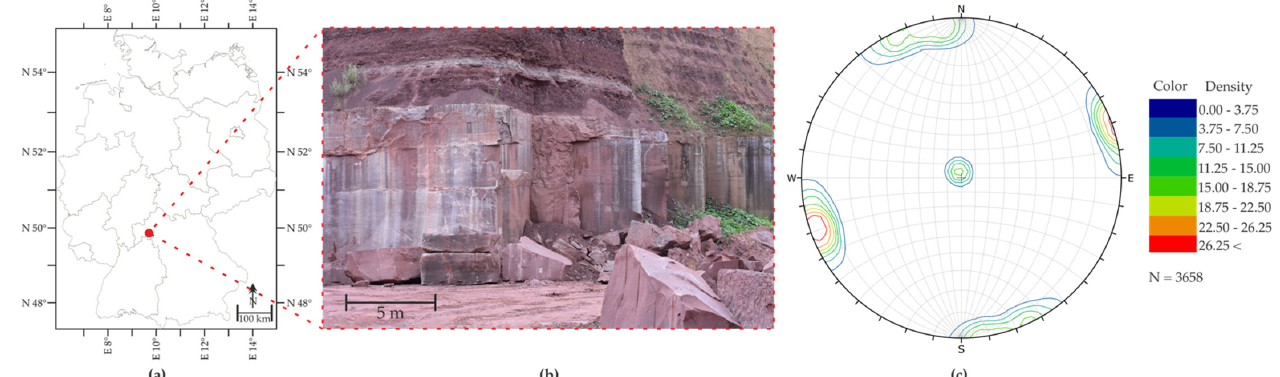
Table 2. Rock mechanical parameters for the Remlingen quarry, including mean and standard deviation [50].